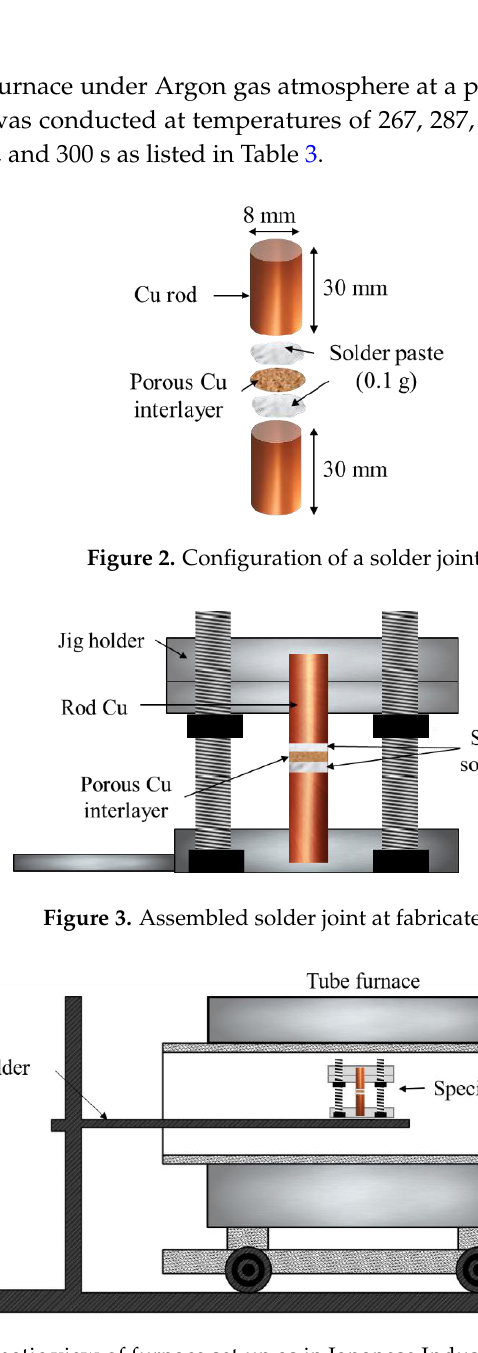
Figure 4. Schematic view of furnace set up as in Japanese Industrial Standard, JISZ 3191. Table 3. Parameters setting for mechanical testing.